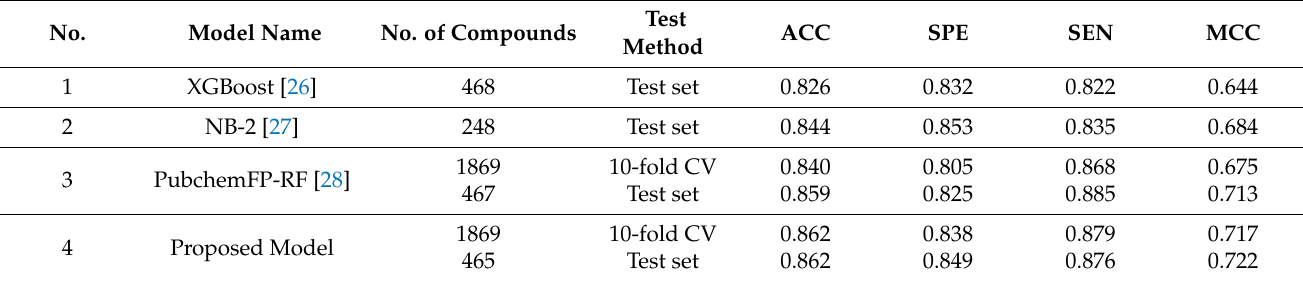
Figure 6. ( a ) Radar chart for 10-fold cross-validation performance comparison of ML models. ( b ) AU- ROC plots comparison for of ML models using 10-fold cross-validation. ( c ) Radar chart for comparing the proposed SVM model performance on respiratory toxicity training (10-fold CV), test and external validation data. Table 4. Comparison with existing